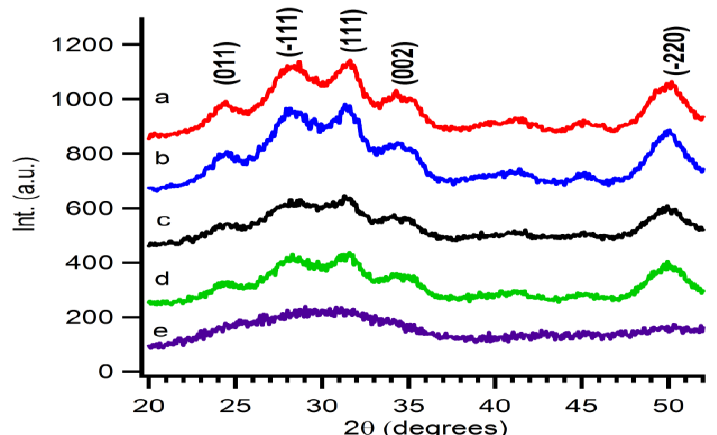
Figure 2. XRD patterns of precipitated particles derived from microwave treated solution A at ( a ) 160 °C for 5 min; ( b ) 150 °C for 30 min; ( c ) 150° C for 5 min; ( d ) 140 °C for 60 min; and ( e ) 140 °C for 5